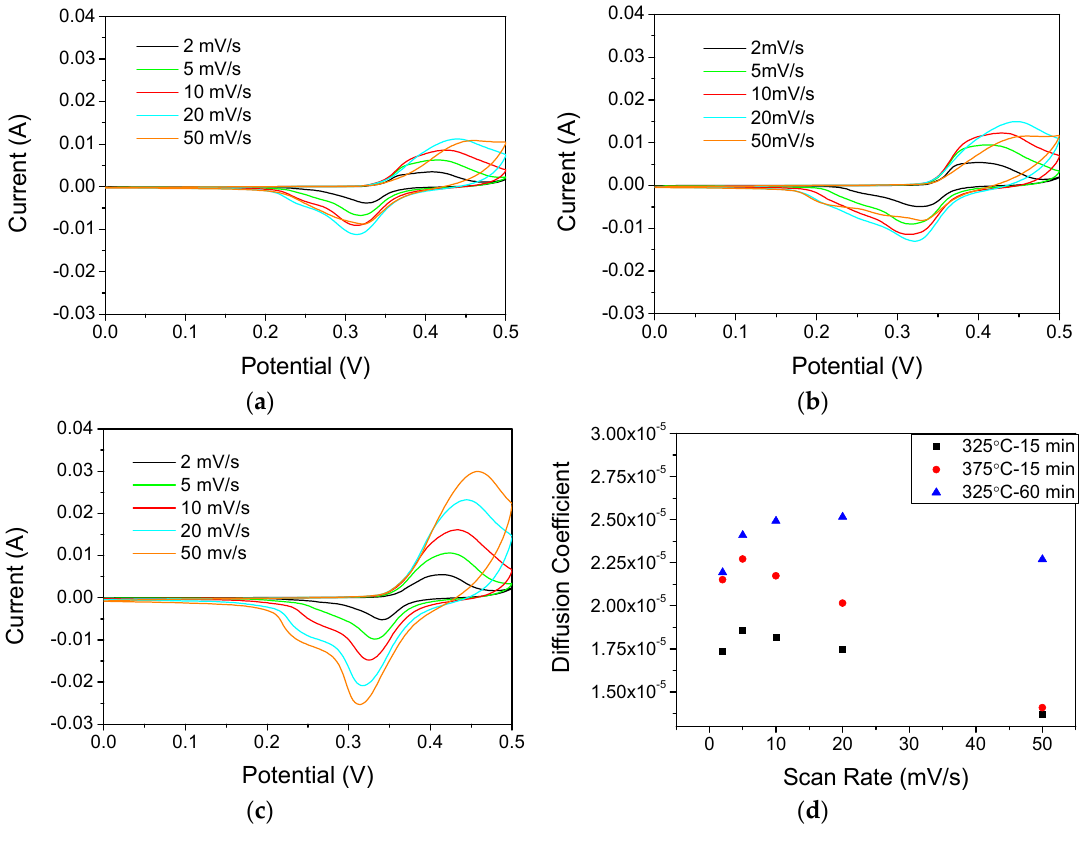
Figure 7. Cyclic voltammetry of NiO ‐ Ni deposits calcined at 325 °C ‐ 15 min ( a ), 375 °C ‐ 15 min ( b ) and 325 °C ‐ 60 min ( c ). Diffusion coefficient calculated by the Randles–Sevcik equation for the different heat treatments ( d ).